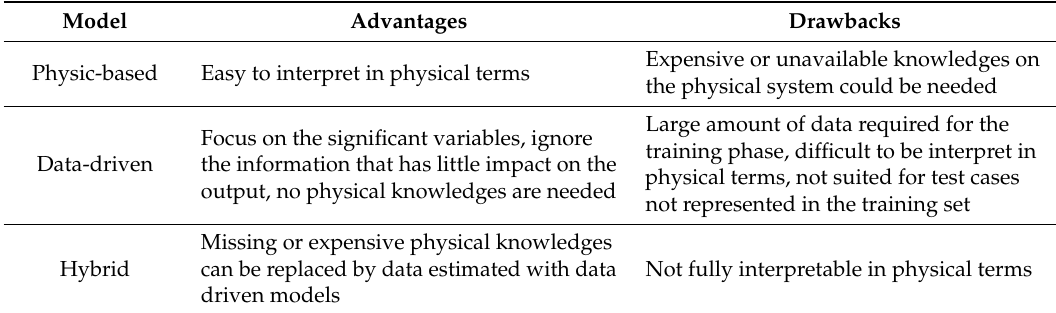
Table 2. Advantages and drawbacks of the electricity load forecasting